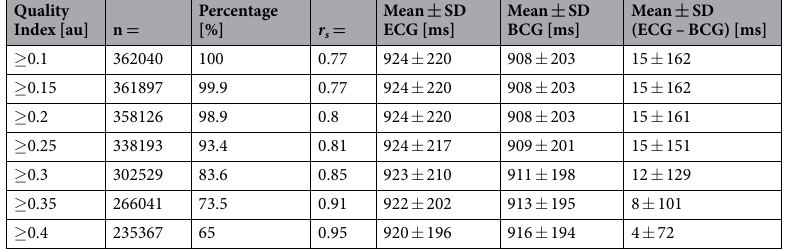
Table 2. Analysed RR intervals by the BCG algorithm and correlation coefficient of the simultaneously recorded ECG filtered by QI and corresponding mean ECG, BCG cycle length and the absolute difference between ECG and BCG cycle length.